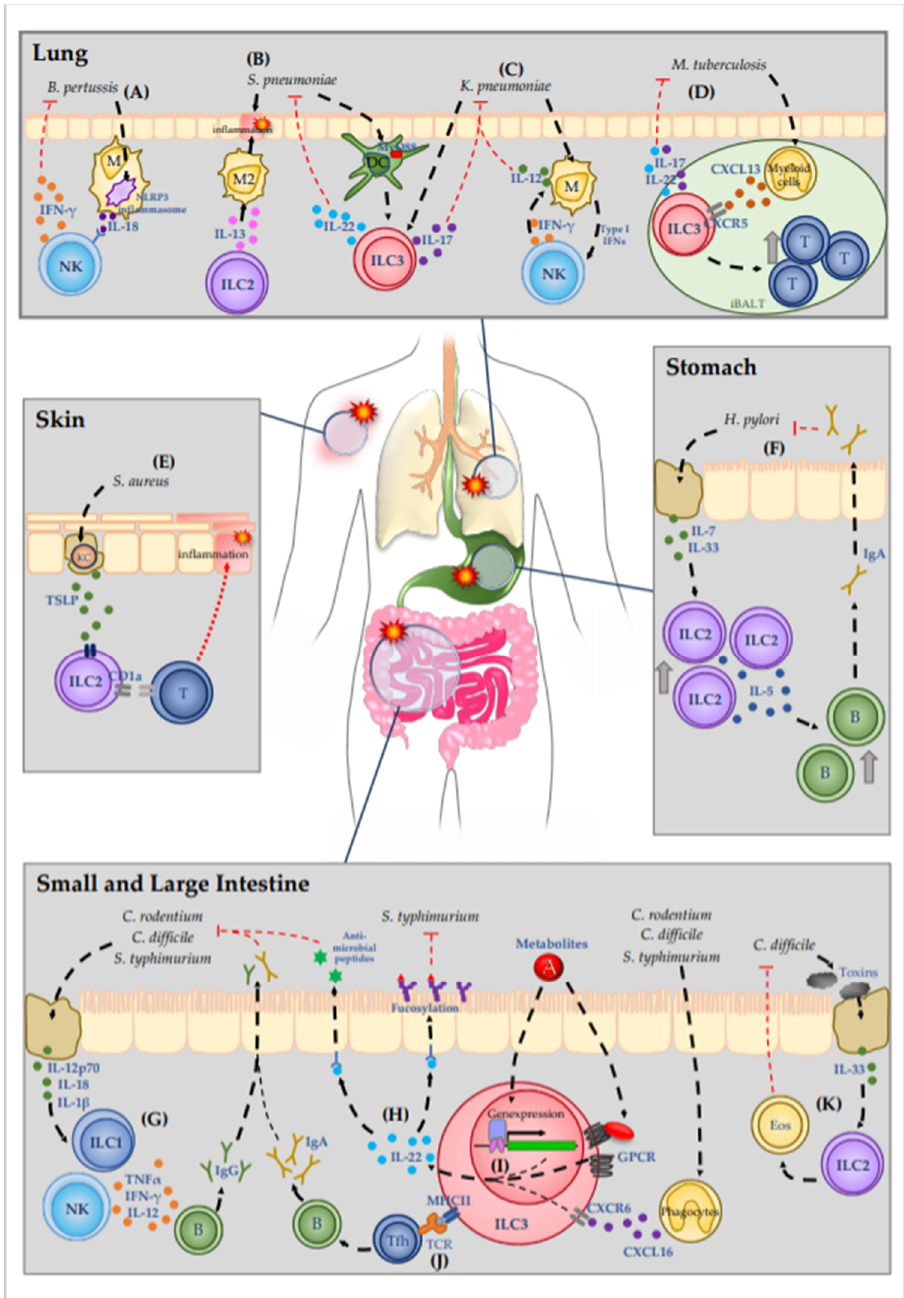
Figure 1. Molecular mechanisms of ILC-mediated immune defense against bacterial infections.Mucosal tissues are sites that are especially prone to bacterial infection due to the high prevalence of pathogenic bacteria. ( A ) B. pertussis causes the severe respiratory infection pertussis. Detection of B. pertussis by macrophages initiates IL-18 release via NLPR3 inflammasome activation, which promotes IFN-γ release from NK cells. ( B , C ) In the lung pneumonia can be caused by the pathogens S. pneumoniae and K. pneumoniae . ( B ) ILC-2-drived IL-13 mediates early polarization of alveolar macrophages into the M2 phenotype. The quiescent immune environment delays the immune response against S. pneumoniae . S. pneumoniae is further detected by DC, which then activate ILC3 in a MyD88-dendent manner, resulting in the production of IL-22. ( C ) ILC3 are also activated during K. pneumoniae infection, increasing IL-17 expression. A mutual interaction of macrophages and NK cells results in IL-12 release from macrophages that plays a critical role in K. pneumoniae containment. ( D ) M. tuberculosis infection induces CXCL13 secretion by myeloid cells in the lymphoid tissue. CXCL13 activates ILC3 via CXCR5, inducing the secretion of IL-22 and IL-17. Moreover, activated ILC3 promotes lymphocyte recruitment to the iBALT site, thus inhibiting infection